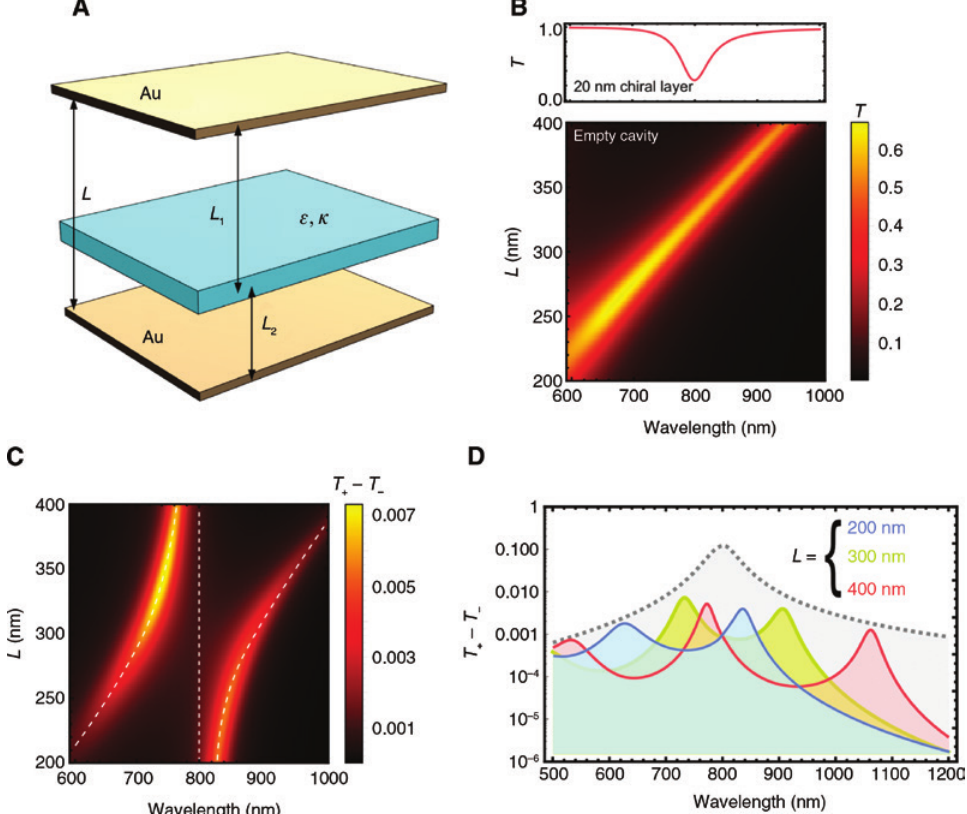
Figure 2: Transfer-matrix calculations of a chiral multilayer system. (A) Sketch of the system studied with the TMM method: a bi-isotropic chiral layer characterized by a resonant permittivity ε and Pasteur parameter κ placed between two gold mirrors. (B) Transmission spectrum of a 20 nm thick bi-isotropic chiral layer in free space, and transmission spectra of an empty cavity as a function of its thickness. (C) CD spectra of the coupled system with the chiral film placed in the middle of the cavity as the function of the cavity thickness. (D) CD spectra of the 20 nm thick chiral film placed in the middle of the cavity of various thicknesses (solid curves) compared to that of the same film in vacuum (dashed grey). Note logarithmic scale in y